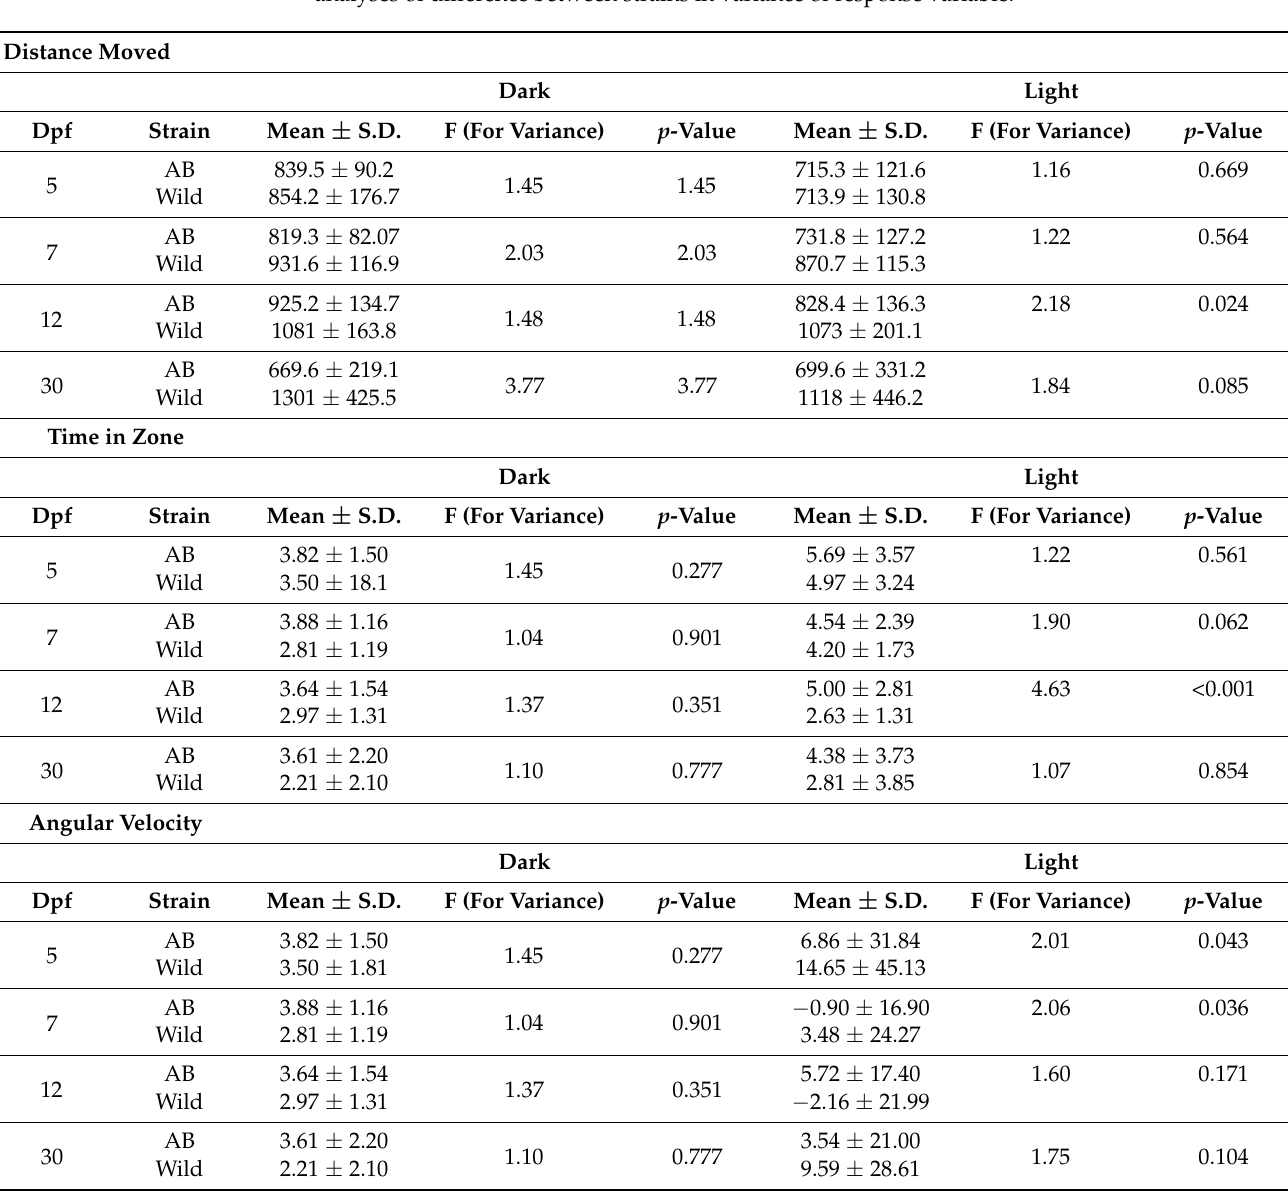
Table 3. Means and standard deviation for corrected values of; time in zone, distance moved and angular velocity for dark and light period (using residuals of response variable on length) and analyses of difference between strains in variance of response